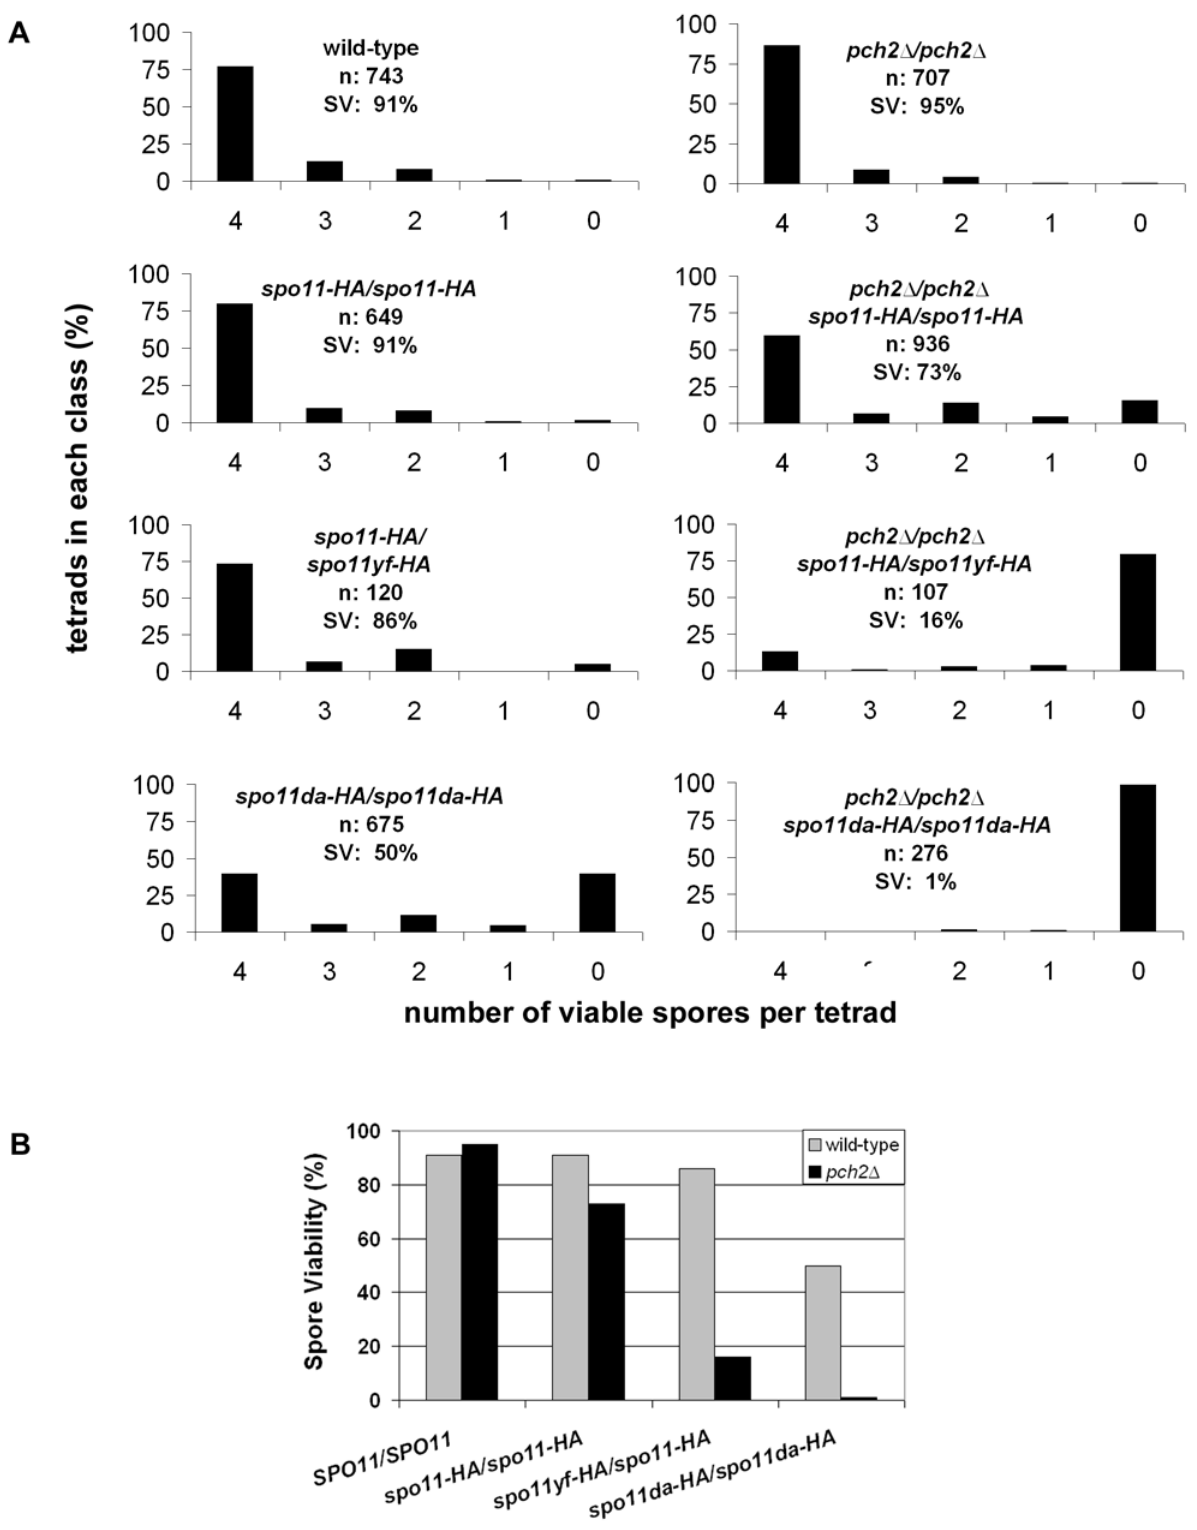
Figure 3. Pch2 promotes spore viability in spo11 hypomorphs. (A) Spore viability distributions of wild-type and mutant strains in the NHY942/ NHY943 strain background are displayed. The X-axes represent the number of viable spores per tetrad and the Y-axes represent the percent of tetrads comprising each class. The total number of tetrads dissected (n) and the overall percent spore viability (% SV) are shown. (B) Bar graph showing spore viability in wild-type (gray) and pch2 D (black) mutants containing the indicated spo11 mutations. The SPO11/SPO11 , spo11-HA/spo11- HA , spo11-HA/spo11yf-HA , and spo11da-HA/spo11da-HA alleles confer 100, 80, 30 and 20% total DSB levels, respectively, in the PCH2 background [32].